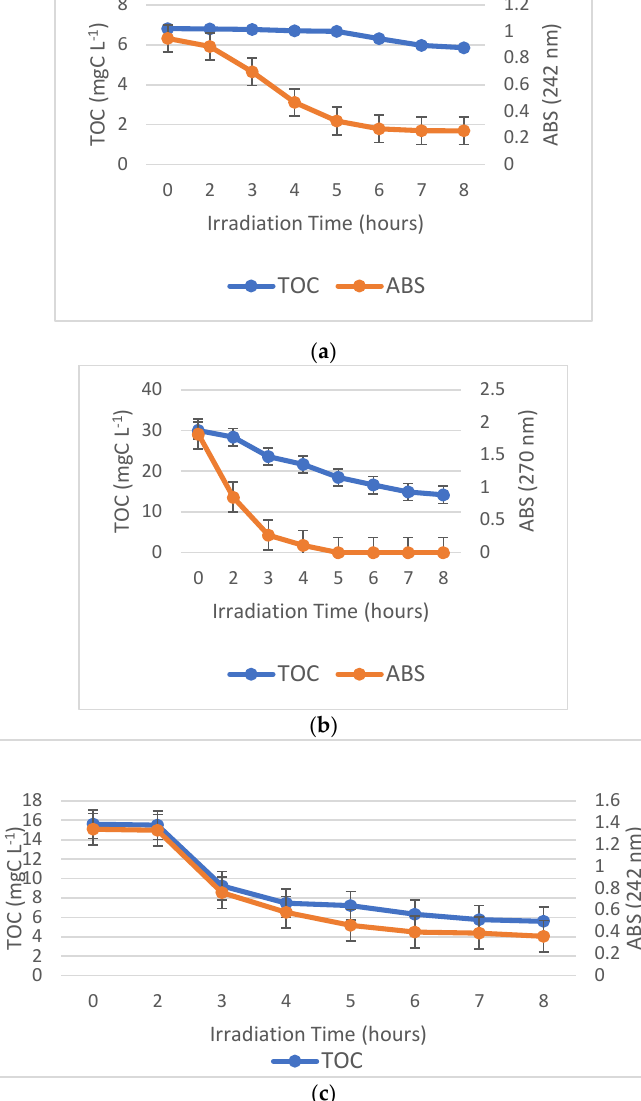
Figure 4. The changes in both the active ingredient concentration and in the TOC content over time with respect to the untreated solutions (irradiation time 0). ( a ) TBA, ( b ) IMI, ( c ) AZO. Concerning the selected pesticides, these differences were particularly evident for the compound TBA. This molecule, or better its degradation derivatives, resulted in being the most recalcitrant. TBA was degraded at 80% after about 6 h, but the TOC value of the solution was quite unaffected after 8 h of treatment (Figure 4a). A similar, and definitely less pronounced, discrepancy between the two processes was observed for the insecticide IMI; the parental molecule completely disappeared after 5 h of treatment, while to halve the TOC value, 7 h of irradiation was required (Figure 4b). On the opposite, the two phenomena showed the same trend in the case of AZO. The disappearance of the active ingredient was strictly followed by the reduction of the TOC value, both halved after 3 h of treatment. After this time, the two curves slightly diverged, probably because of the formation of resistant photoproducts (Figure 4c).